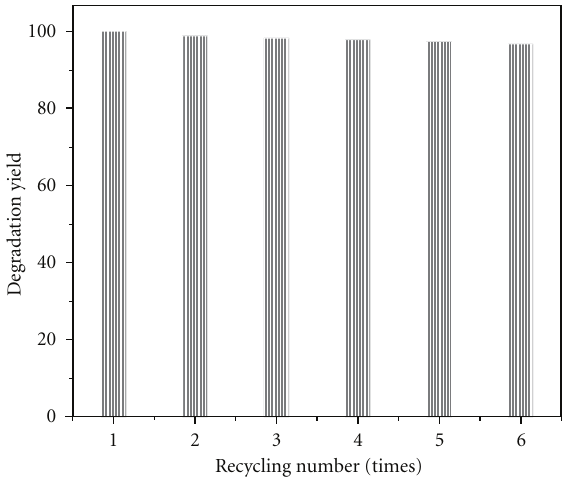
Figure 7: Recycling test result by using the IT-400 sample.